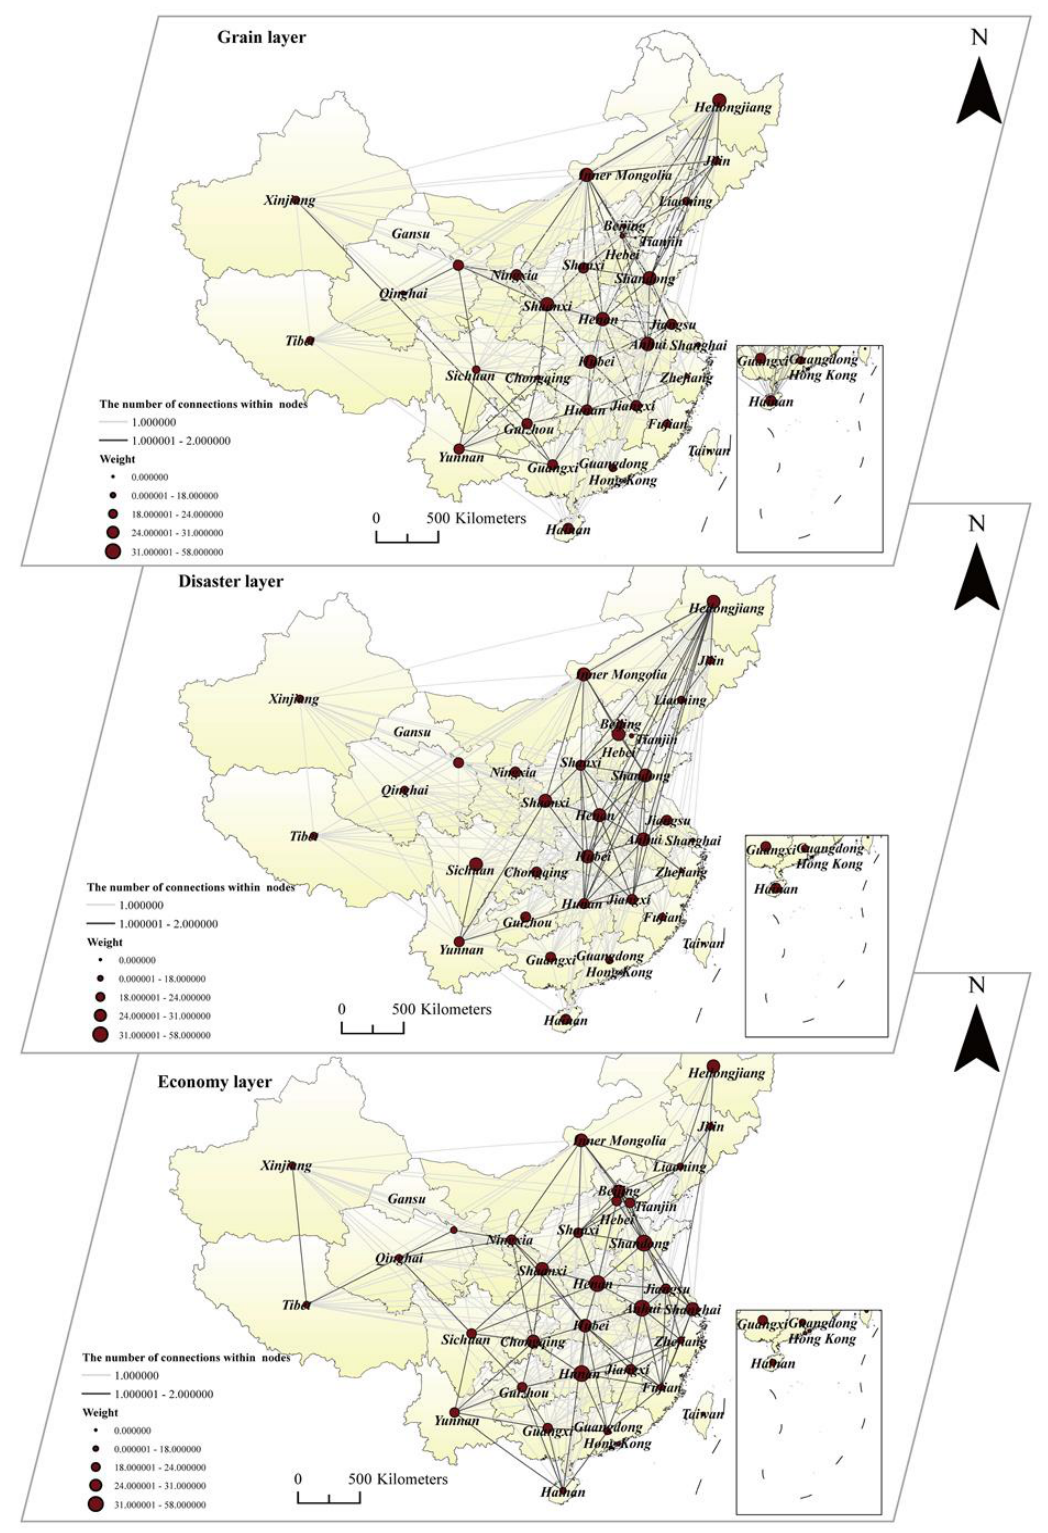
Figure 5. The correlation strength of node in grain–disaster–economy multilayer network in